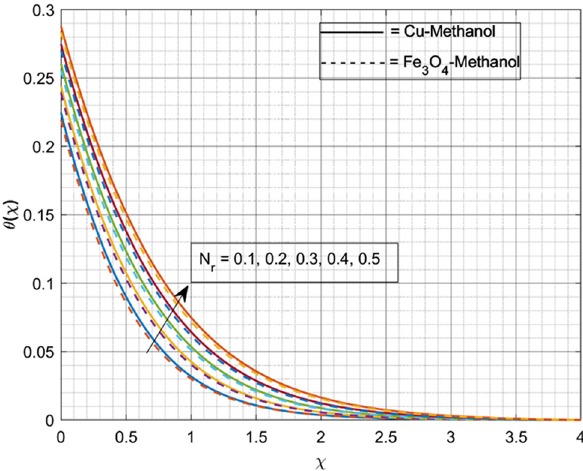
Figure 9: Sway of N r on θ